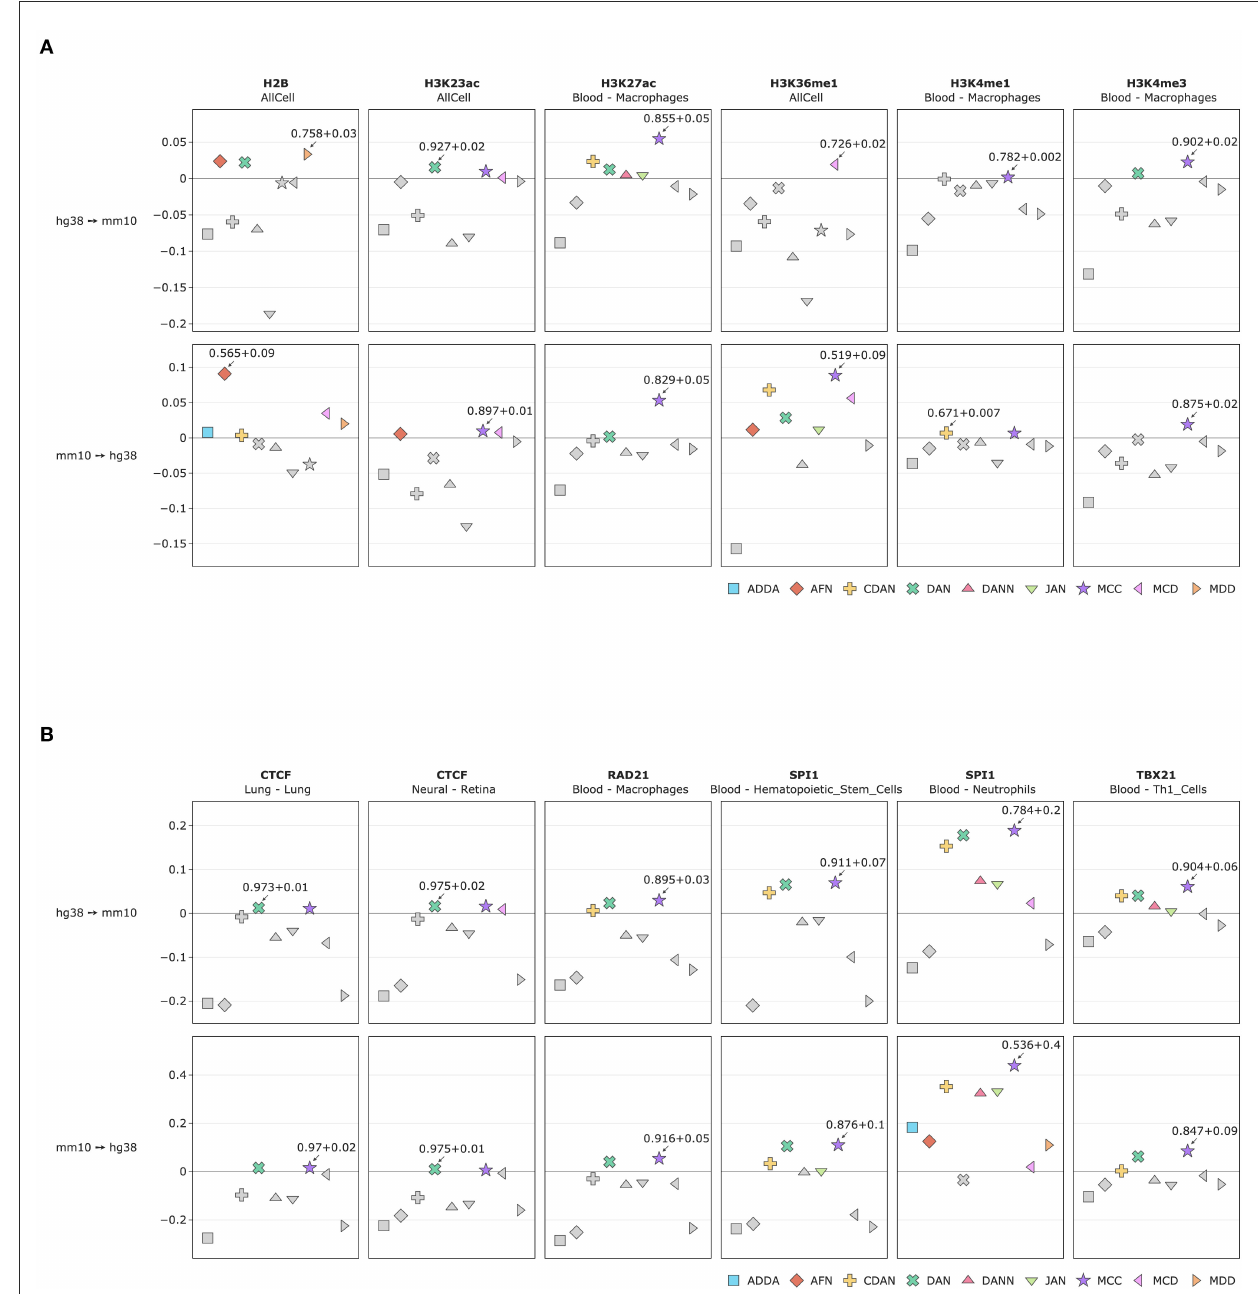
FIGURE4 Comparative performance (ROC AUC) of Domain Adaptation methods for cross-species prediction of (A) 6 selected histone marks and (B) 6 selected transcription factors. Y axis depicts difference between DA performance metrics (ROC AUC) with respect to the baseline model, i.e., model trained on the source genome and applied to the target genome directly without DA approach (see comparison based on PR AUC and accuracy in Supplementary Figure 1). The best performing DA model is marked with an arrow with the corresponding metrics of the baseline model plus a gain in performance achieved by the DA model. See full list of experiments in Supplementary Table